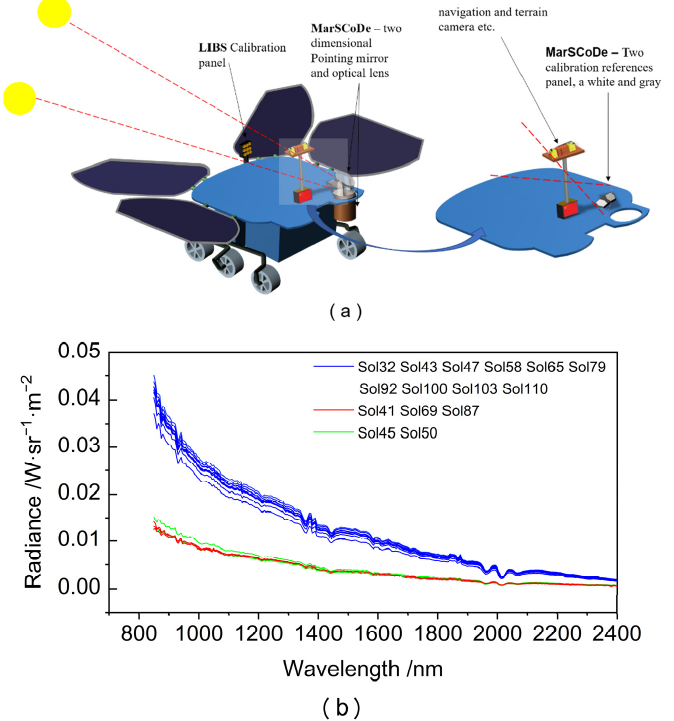
Figure 4. Schematic diagram of simulated incident light blocked by Mars rover mechanics and gray panel spoke brightness statistics. ( a ) Schematic of the Mars rover light, where it can be seen that when the light is incident in the body coordinate system in the Yr direction, it will lead to the projection of the Mars rover with sensors such as the navigation, terrain camera, etc., to the plane of the calibration panel. ( b ) Gray panel irradiance statistics for 15 sols (blue indicates normal conditions; red indicates blocked; cyan indicates a large angle of incidence and the possibility of being blocked at the same